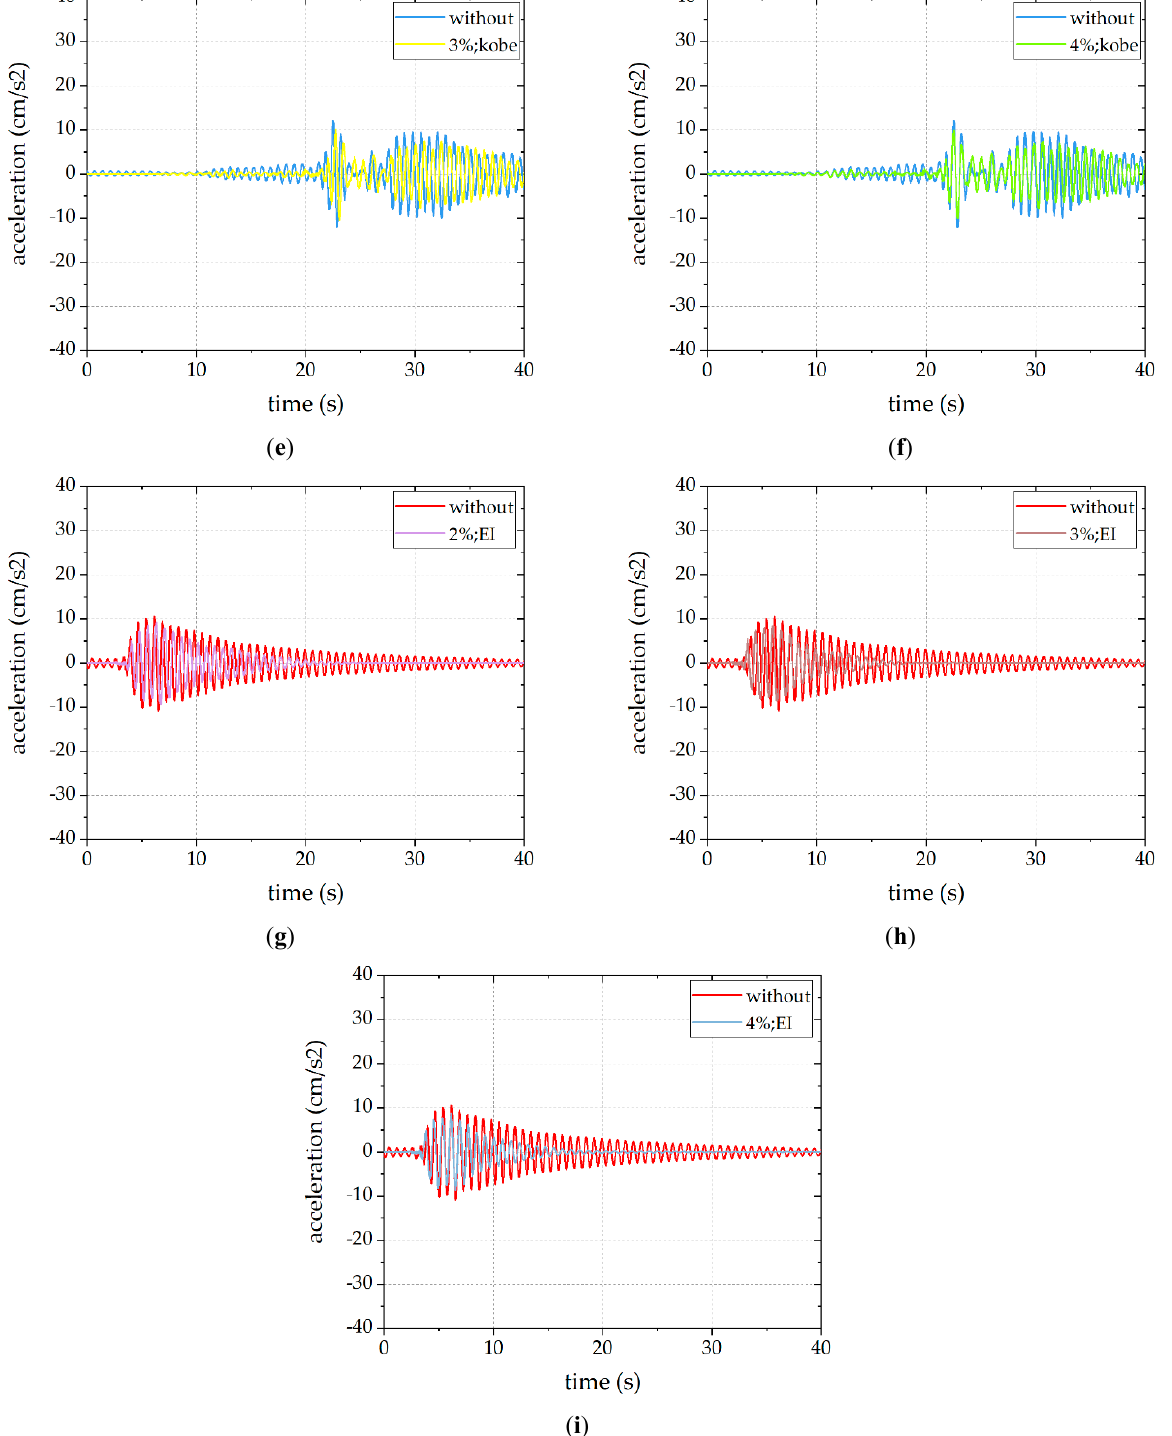
Figure 4. Acceleration time curve (2%, 3%, and 4% are mass ratios): ( a ) sine; 2%; ( b ) sine; 3%; ( c ) sine; 4%; ( d ) Kobe; 2%; ( e ) Kobe; 3%; ( f ) Kobe; 4%; ( g ) El-Centro; 2%; ( h ) El-Centro; 3%; ( i ) El-Centro; 4%. Note: to simplify the image annotation, “El” in figures is used to represent the El-Centro wave, “sine” means sine wave, “kobe” means Kobe wave; and the remaining figures are the same.